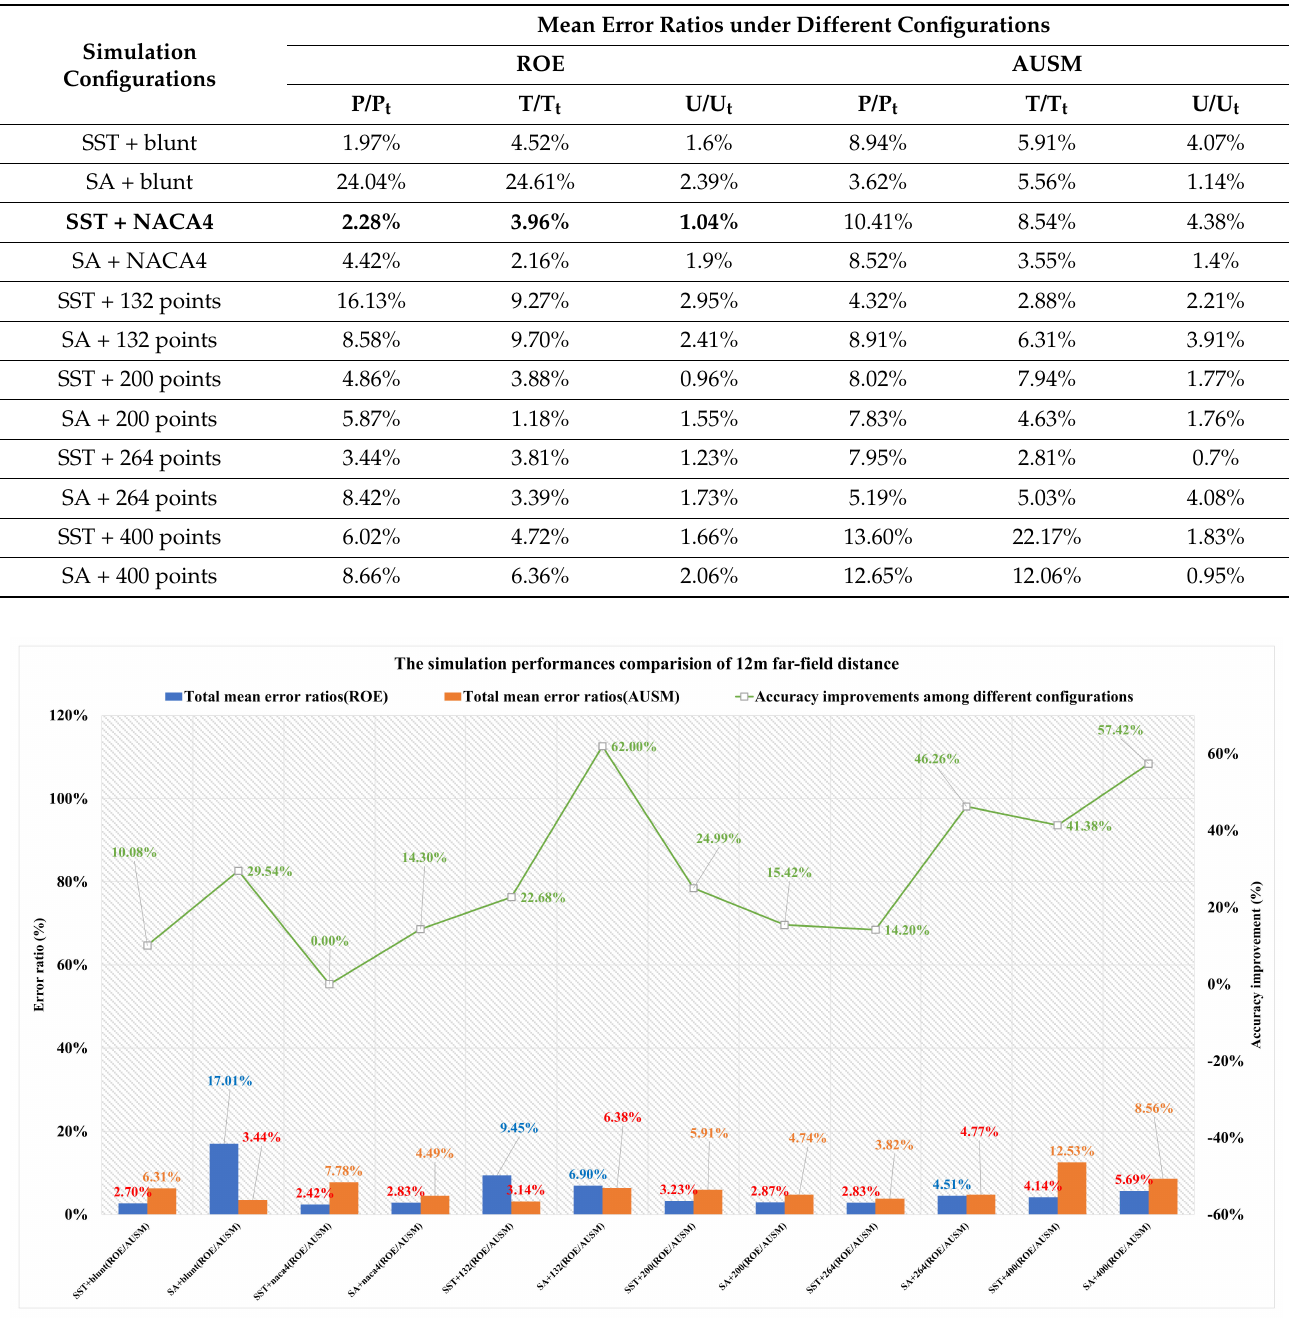
Table 18. The mean error ratios of P/P t , T/T t , and U/U t of the 12 m far-field distance.